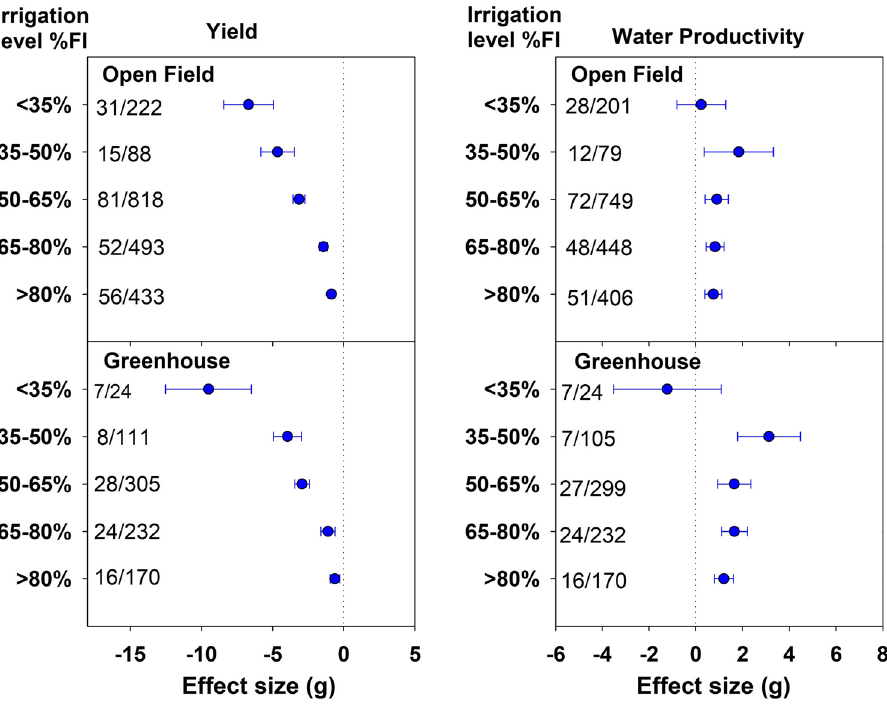
Figure 5. Effect of deficit irrigation levels on yield and water productivity (WP) under open-field and greenhouse conditions. The dotted line (effect size = 0) represents full irrigation. Effect size > 0 indicates increase and effect size < 0 indicates reduction in yield and WP for deficit irrigation level relative to full irrigation (FI). Non-overlapping confidence intervals (horizontal bars) indicate significant differences. Numbers on right side of Y-axis represent number of